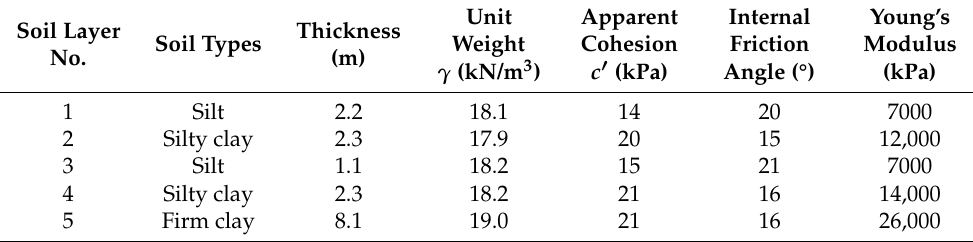
Figure 1. Layout of nail positions, excavation sequences and levels and the finite element mesh adopted in this study. Table 1. Thickness of soil layers and list of soil parameters used in the numerical